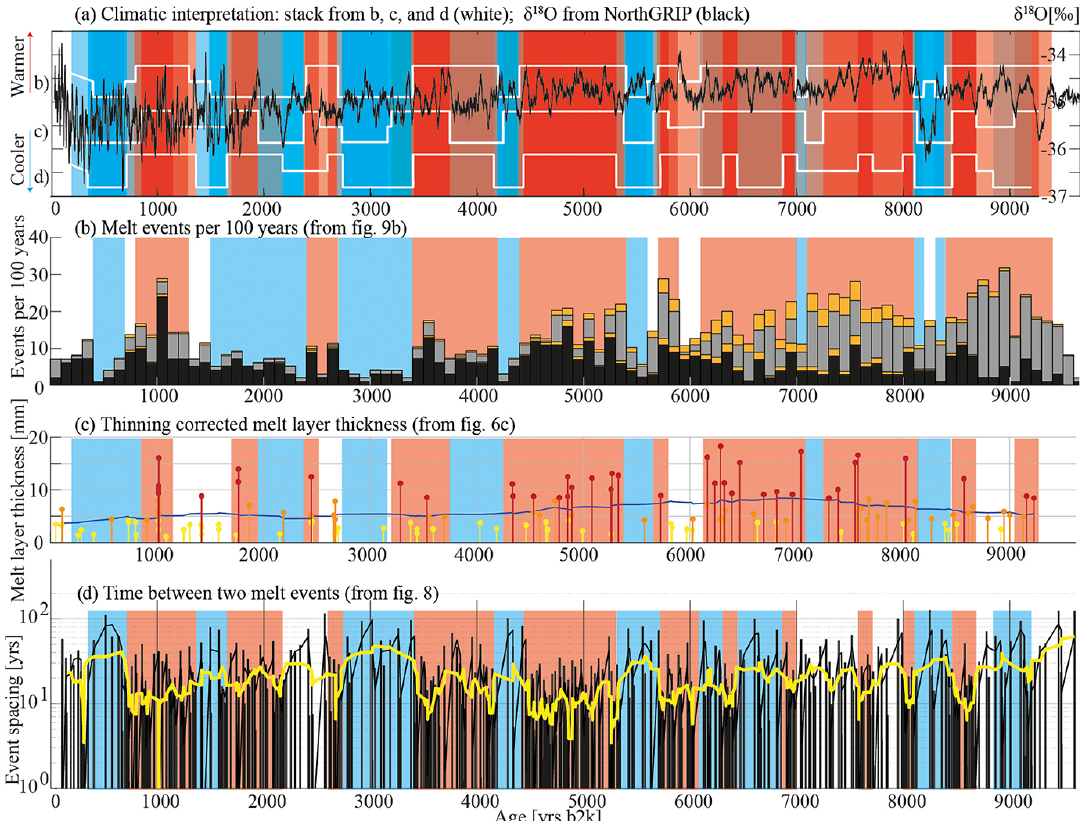
Figure A6. (a) A climatic interpretation of Holocene summer temperatures from the melt layer distribution over the Holocene. Without providing absolute values, red represents warmer periods and blue colder ones. The white lines are climatic interpretations from (b) , (c) , and (d) , and the red and blue shading represents (b) , (c) , and (d) stacked. The stable oxygen isotope ( δ 18 O) record from NorthGRIP is shown in black (North GRIP members, 2004). (b) Melt events per 100 years (Fig. 6b), with red shading indicating periods with many events and blue indicating periods with fewer events. (c) Melt layer thickness (Fig. 7c), with red shading indicating periods with thick melt layers. (d) Melt event frequencies, with short time spans between melt events shown in red and long time spans in blue. The running mean is shown in